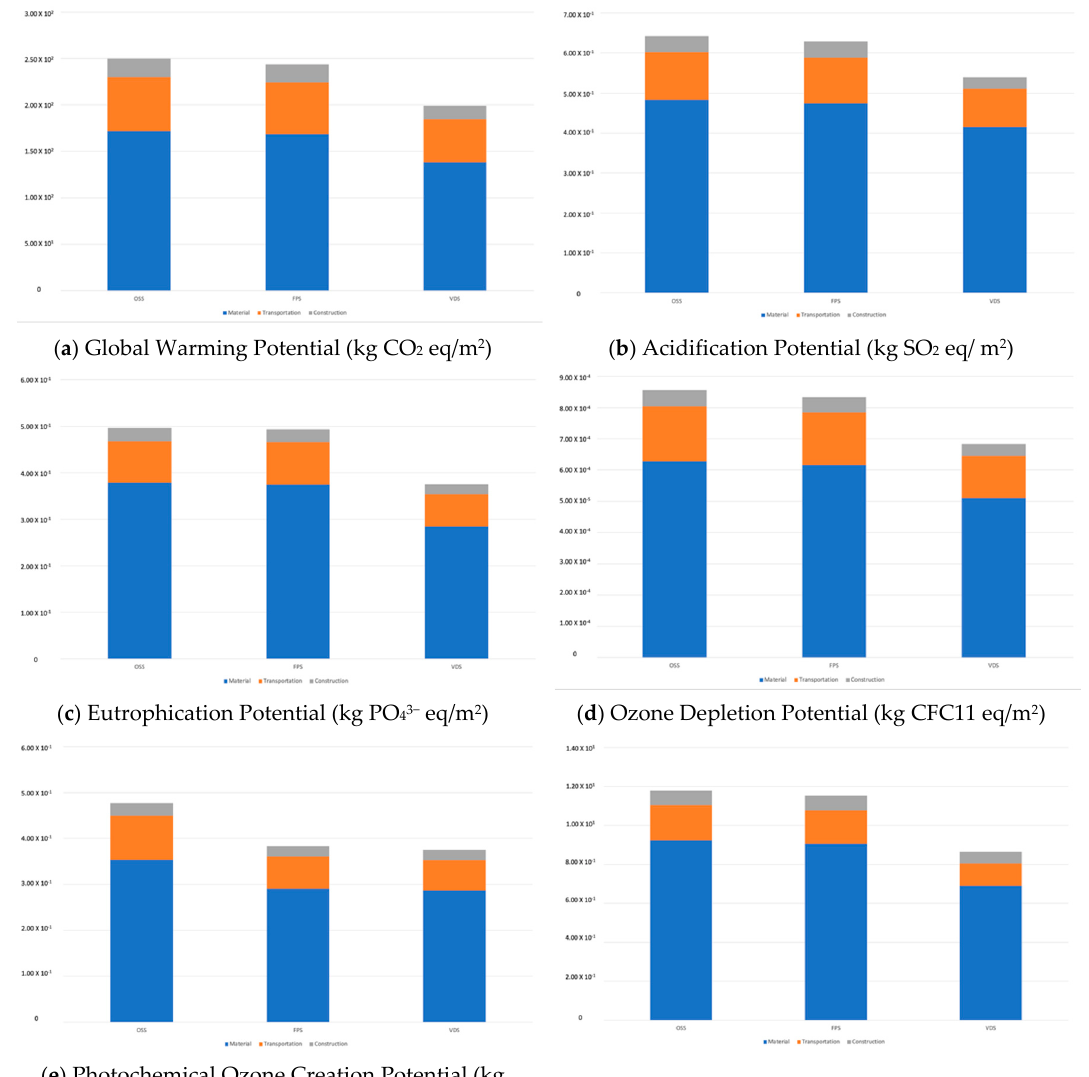
Figure 5. Reduction in environmental impacts.